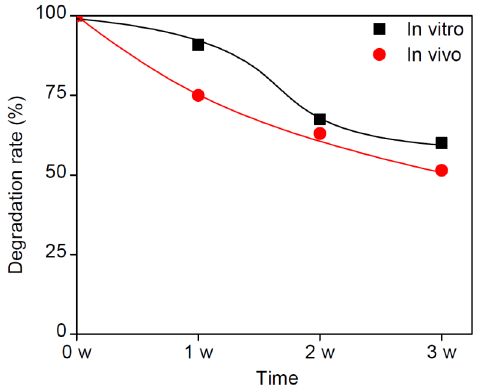
Figure 3. Plot of degraded PCLA as a function of time; the molecular weight of the remained PCLA inside Dex ‐ NS at in vitro and in vivo were determined by 1 H ‐ NMR.